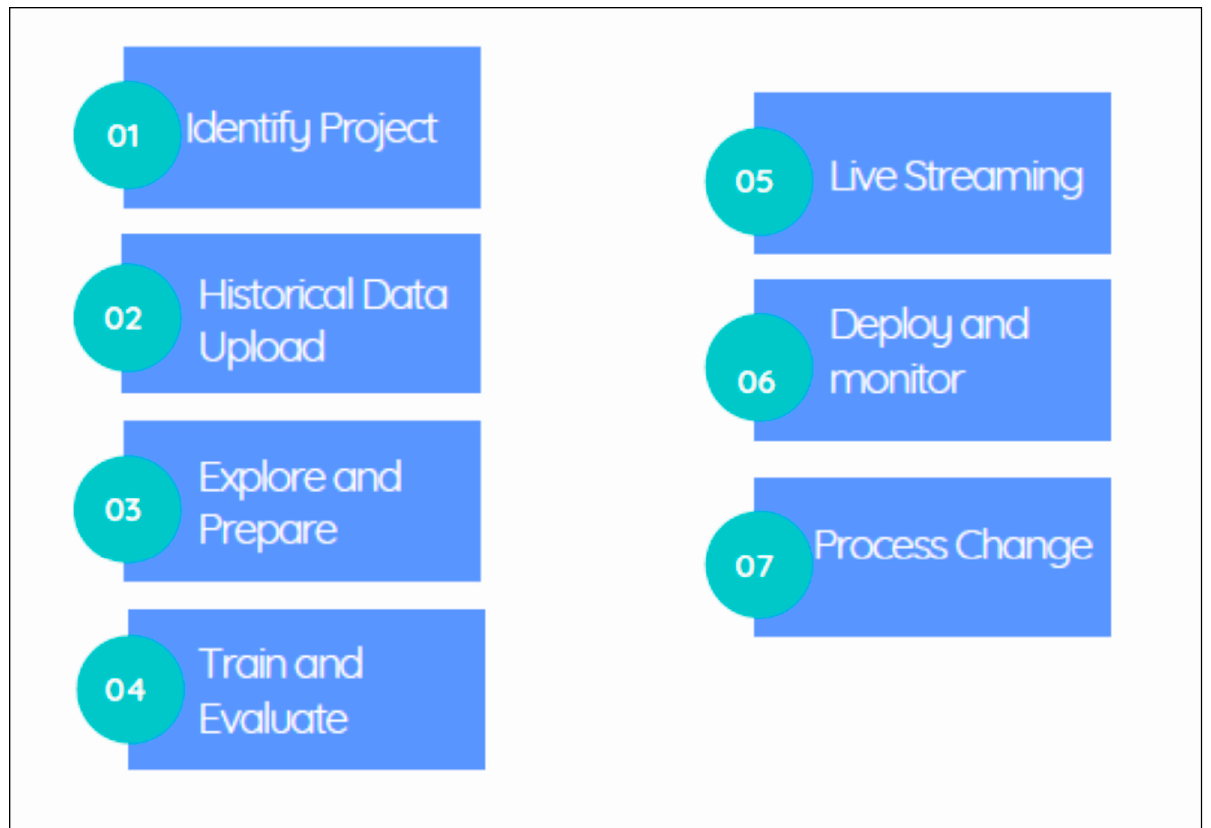
Figure 1. Seven ‐ step process followed at Stelco to obtain results with the CA platform. Figure 1. Seven-step process followed at steel firm to obtain results with the CA